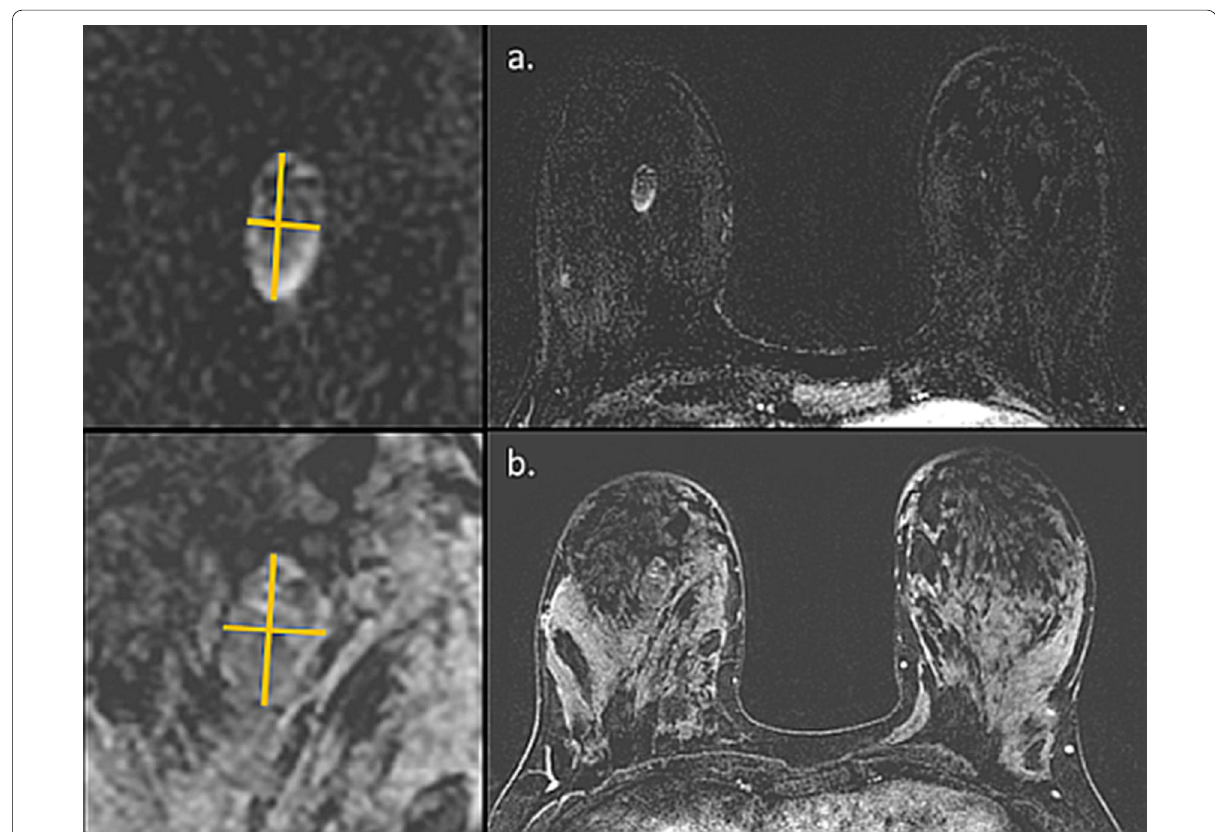
Fig. 6 Growing fibroadenoma during lactation. DCE‑MRI subtracted images of a 26 years BRCA 1 carrier scanned twice within 18 months of routine surveillance, before conception and during lactation are presented. On baseline MRI ( a ), a 1.3 cm well‑defined enhancing oval mass is visible on top of minimal background parenchymal enhancement (BPE 0). Yet, on follow‑up during lactation, a 1.8 cm is hardly visible on DCE, due to the marked physiological BPE (grade 3) ( b ). The lesion enlargement and a personal history of phyllodes tumor prompt a US‑guided biopsy which